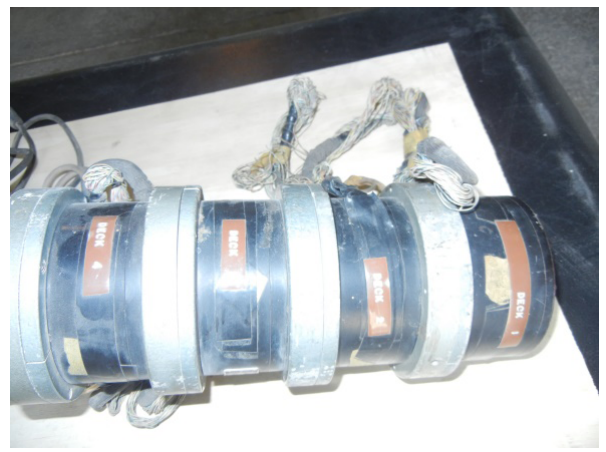
Figure 12. Mercury jet commutator used in the original reception system at